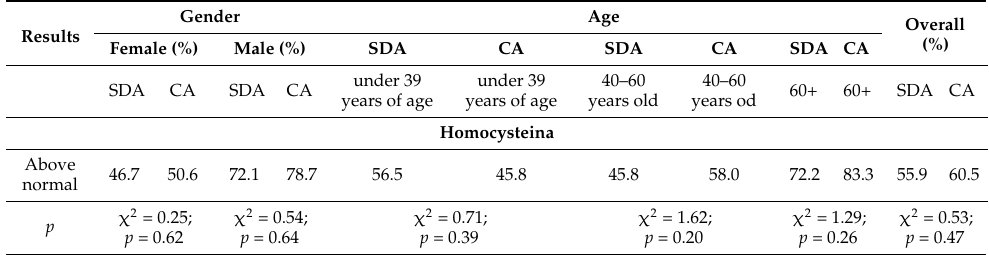
Table 2. Homocysteine results in the study group of SDA and CA: overall, according to age and to